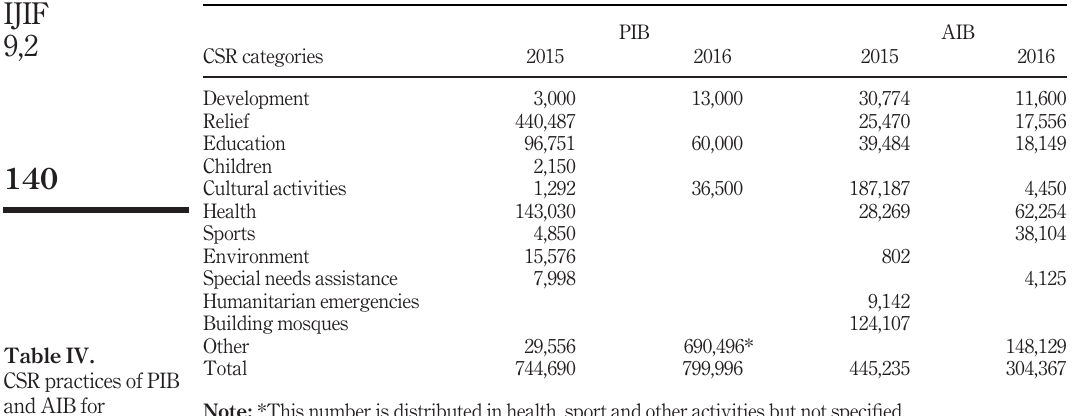
Table IV. CSR practices of PIB and AIB for 2015-2016 (USD)